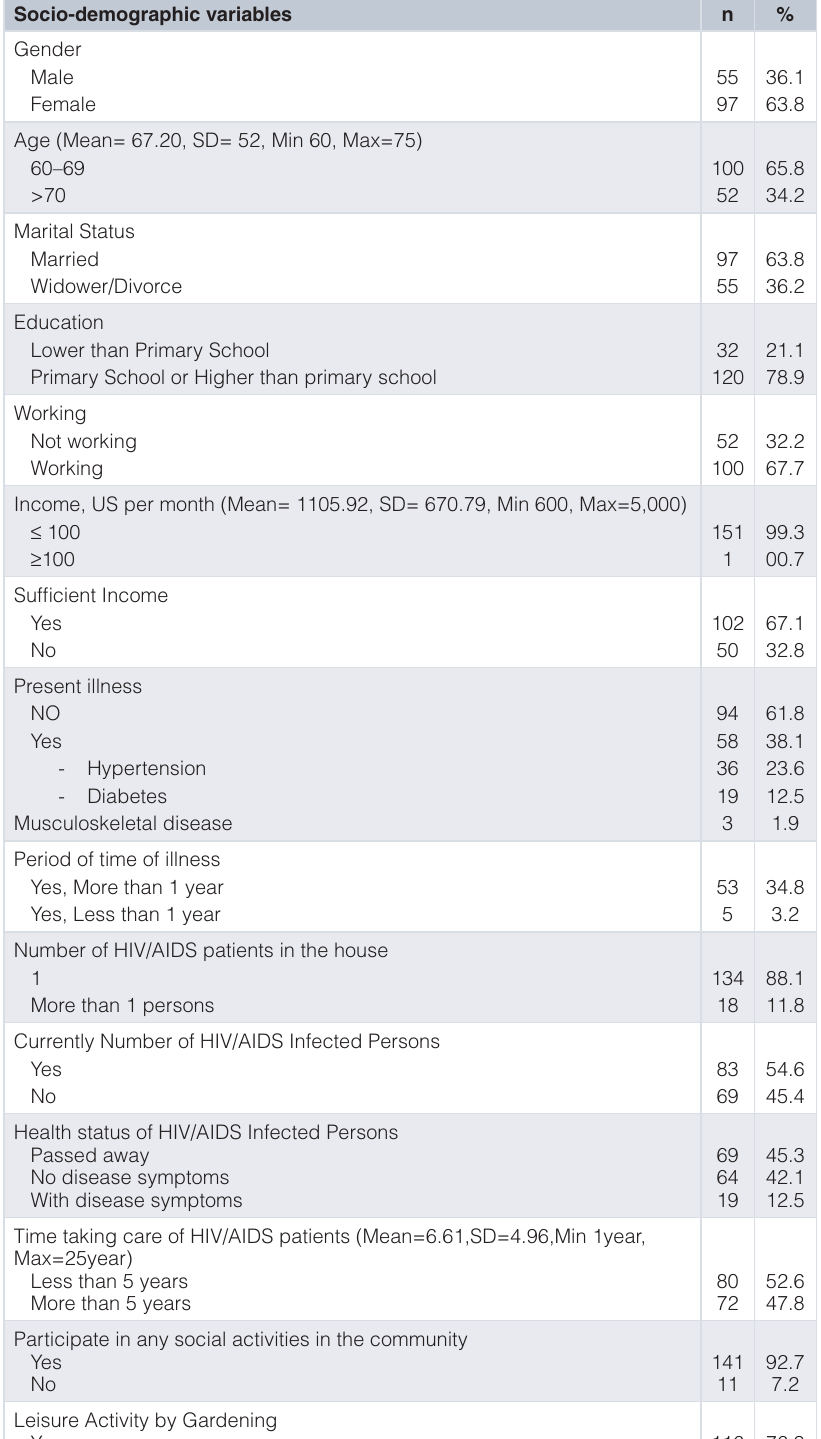
Table 1. Socio - demographic characteristics of